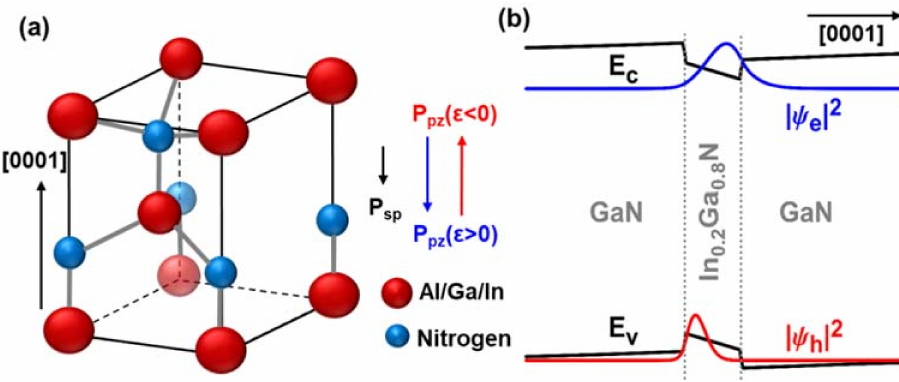
Figure 1. ( a ) Schematic Wurtzite nitride structure and the direction of spontaneous polarization (P sp ) and piezoelectric polarization (P pz ). ( b ) Band diagram of undoped 3 nm GaN/In 0.2 Ga 0.8 N/GaN quantum-well grown along c-axis with wavefunctions in a ground